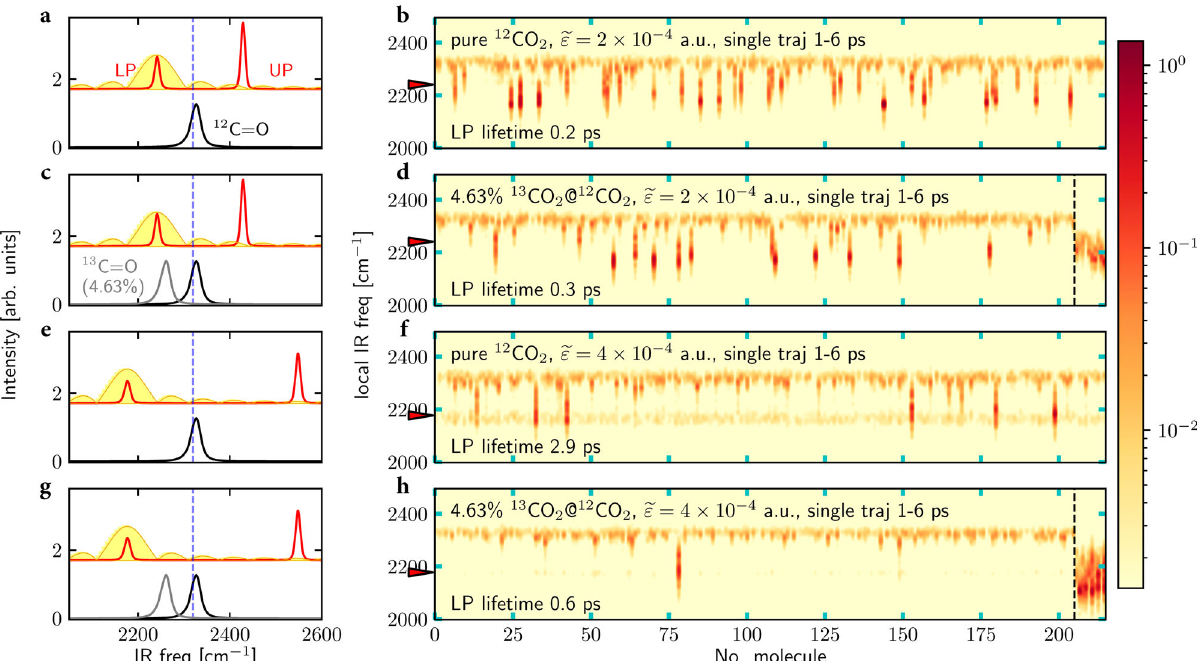
Fig. 2 Rabi splitting and selective polariton energy transfer. a Equilibrium IR spectrum for pure liquid 12 CO 2 outside a cavity (black line) or inside a cavity with coupling e ε ¼ 2 ´ 10 (cid:2) 4 a.u. (red line); the vertical dashed blue line denotes the cavity mode at 2320 cm − 1 . b The corresponding nonequilibrium local IR spectrum for each molecule after a resonant excitation of the LP at 2241 cm − 1 with a strong external pulse. The external pulse takes the form E ð ω t þ ϕ Þ e t < 0.6 ps) with fl uence 632 mJ/cm 2 ; the corresponding pulse spectrum is also plotted as the yellow curve on the left panel. The x (0.1 < 0 cos nonequilibrium spectrum is calculated by evaluating the dipole autocorrelation function of each CO 2 molecule over time interval 1 – 6 ps. The red arrow marks the frequency of the LP and also the external pulse, and the LP lifetime (0.2 ps, calculated from photonic energy dynamics 24 ) is labeled at the bottom. c Equilibrium IR spectrum (red line) for 4.63% 13 CO 2 in a 12 CO 2 solution when e ε ¼ 2 ´ 10 (cid:2) 4 a.u. The gray line denotes the 13 CO 2 IR spectrum outside the cavity; again, the black line denotes the pure 12 CO 2 IR spectrum outside the cavity. d The corresponding nonequilibrium local IR spectrum for each molecule plotted in a similar manner as ( b ). The responses of 12 CO 2 (left) and 13 CO 2 (right) are separated by the vertical dashed line. e – h The same plots as in ( a – d ) but with a larger effective light-matter coupling ( e ε ¼ 4 ´ 10 (cid:2) 4 a.u.). Note that with an appropriate LP frequency, the LP is more likely to transfer energy to the 13 CO 2 solute molecules than to the 12 CO 2 solvent. See Supplementary Methods for simulation details, the de fi nition of the CO 2 force fi eld, and the de fi nition of the spectra